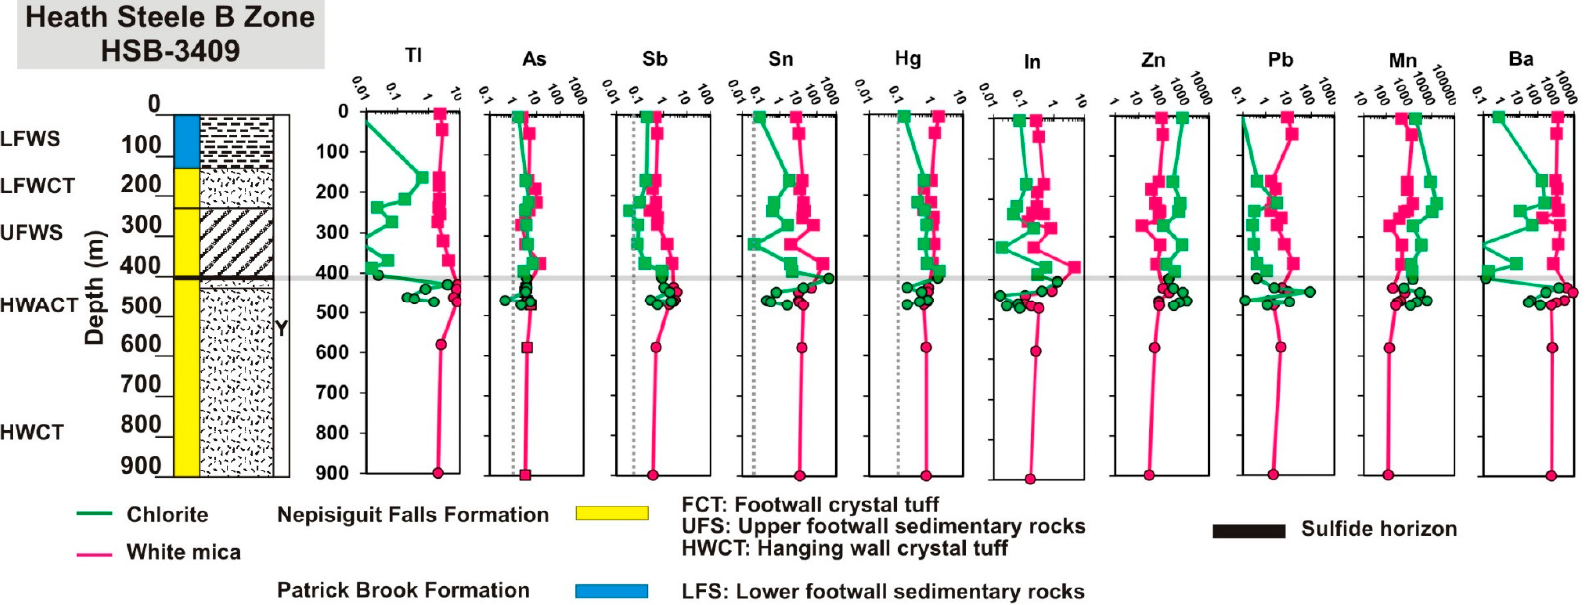
Figure 9. LA-ICP-MS geochemical data profiles illustrating fluid-mobile elements, as well as Zn, Pb, Mn, and Ba content (in ppm) of chlorite (green symbols and lines) and white mica (pink symbols and lines) plotted with respect to stratigraphic profile of the Heath Steele B zone deposit along drill hole HSB-3409 (see Supplementary Tables S6 and S7). Black outline on squares denotes hanging wall samples.